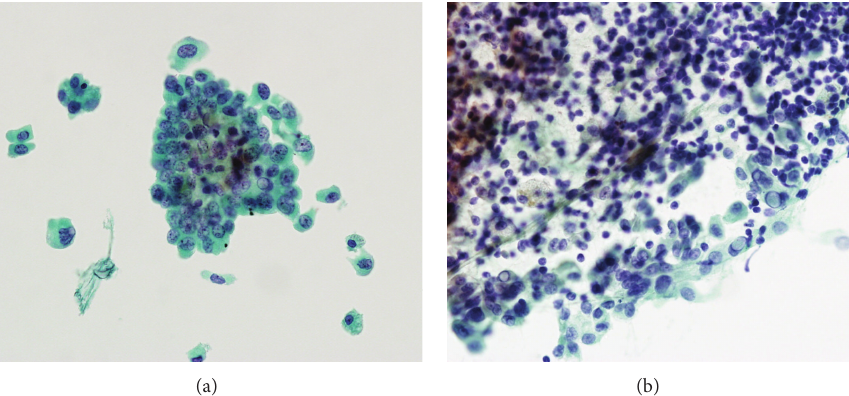
Figure 4: ThinPrep liquid-based cytology and conventional smear of the Warthin-like variant of papillary carcinoma. (a) ThinPrep cytology shows higher cellularity and clean background compared to conventional smear. (b) In the conventional smear, there was dense lymphoplasmacytic infiltration in the cellular